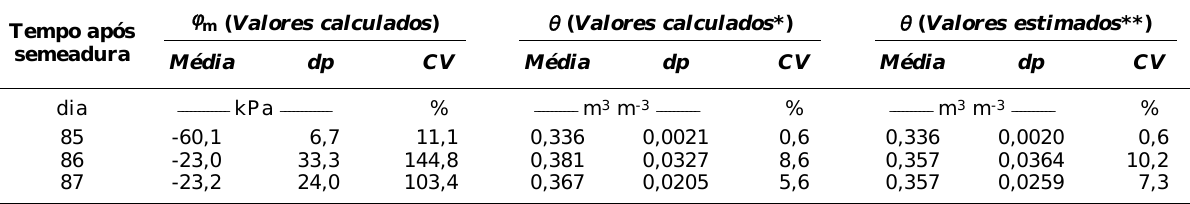
* Calculados diretamente a partir dos valores de q de cada repetição; ** q